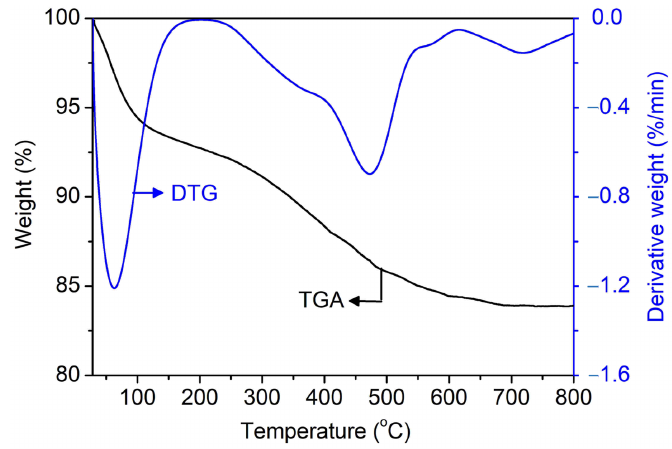
Figure 7. TGA/DTG thermograms of uncalcined SAPO ‐ 34 (S ‐ 3) sample.